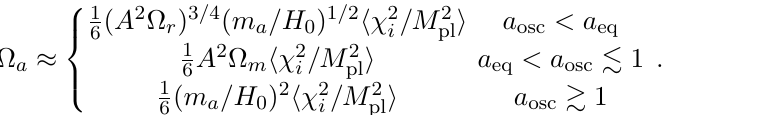
= 10 14 GeV, H = 100 h km ∗ s − 1 Mpc − 1 ( h =0.67), I 0 2 = 0 . 12 . The initial misalignment angle d h & χ 10 14 GeV, generally larger than inflationary Hubble a i >